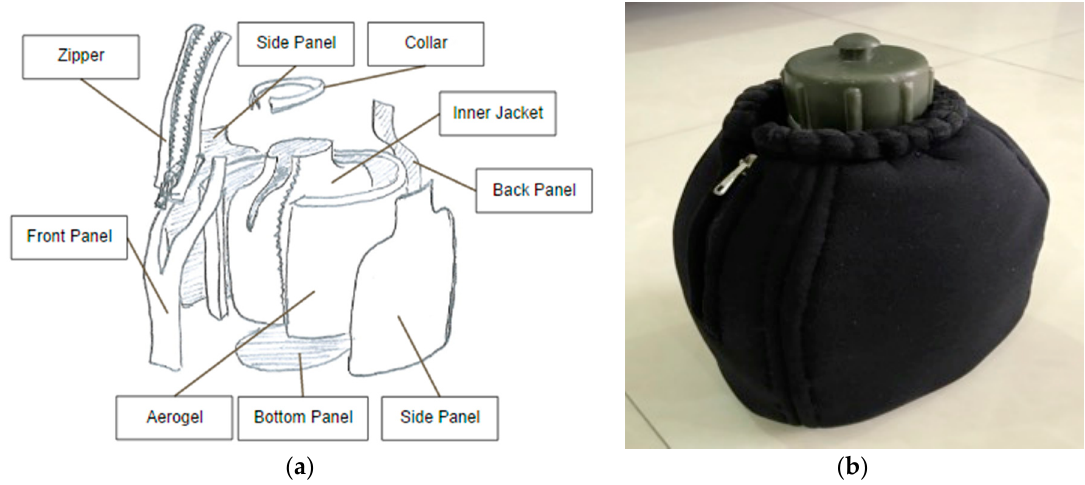
Figure 4. ( a ) Sketch of the insulated jacket and ( b ) final insulated jacket on the military canteen.